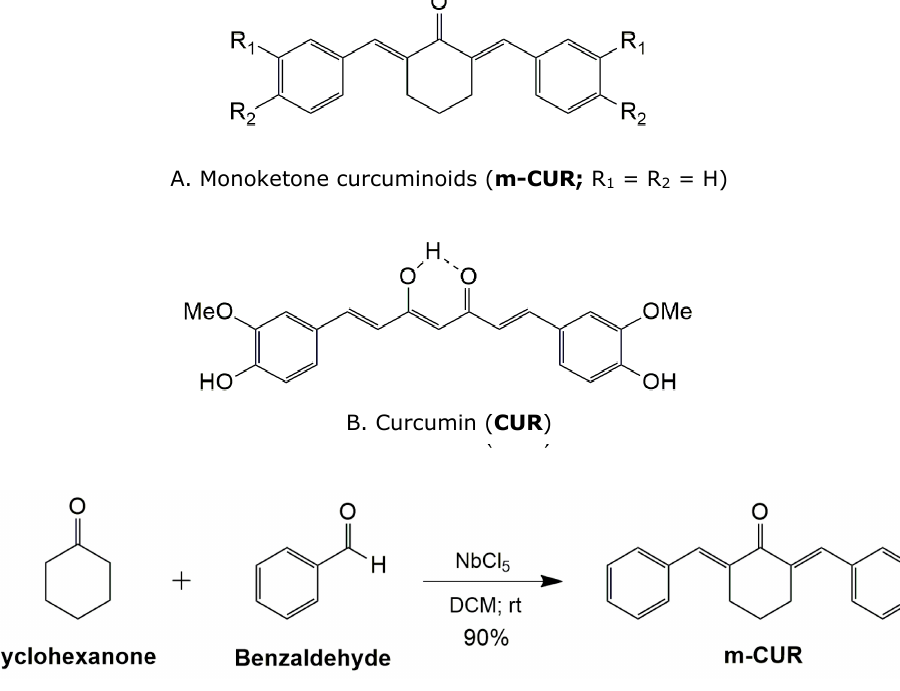
Figure 1. Chemical structure of ( A ) monoketone curcuminoids, ( B ) curcumin, and ( C ) a scheme of the ‘Claisen-Schmidt’ condensation reaction to synthesize the m-CUR.